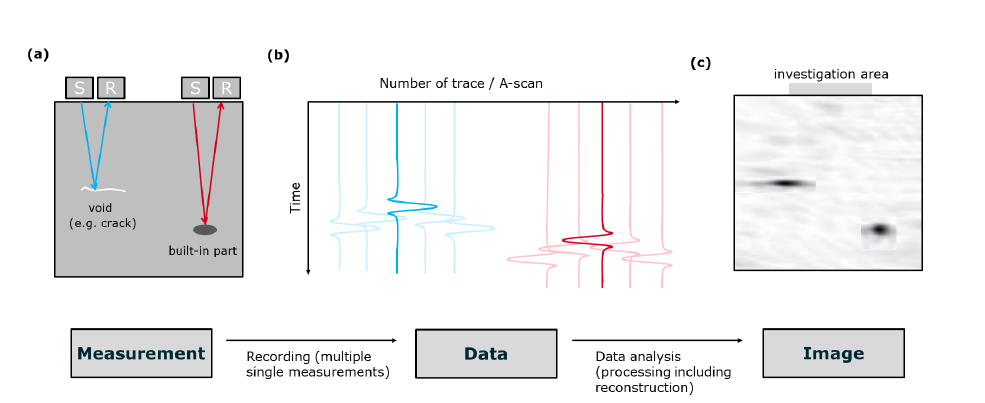
Figure 2. Summary of the applied ultrasonic echo method: ( a ) measurements with sender/receiver pair, ( b ) data represented in the time/space domain, ( c ) reconstructed ultrasonic image in the depth/space